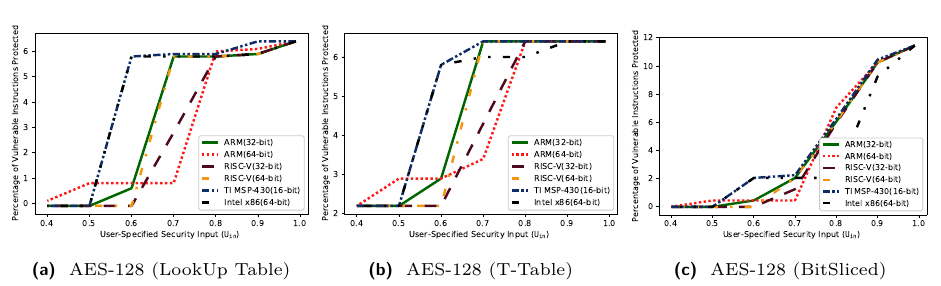
Figure 14: Percentage of vulnerable instructions protected for different user input ( U in ) across six different